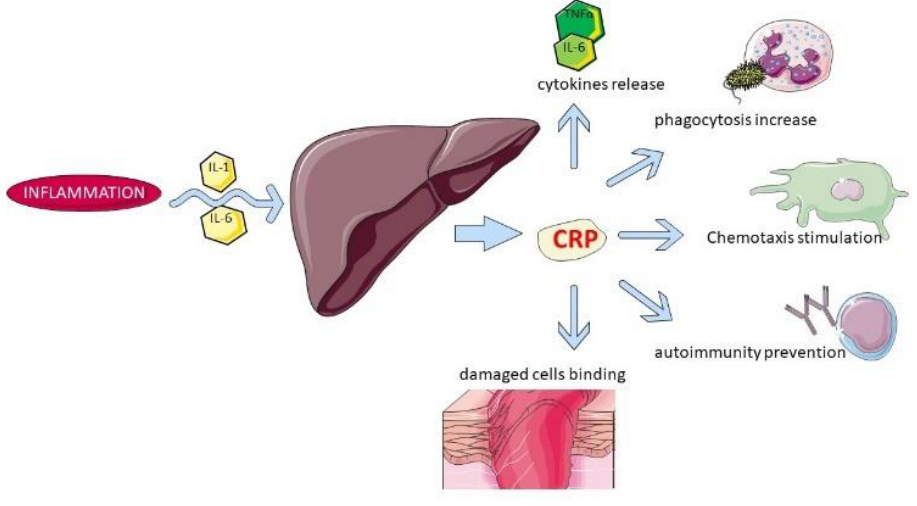
Figure 1. Factors inducing acute phase response, including CRP. The changes in APPs are species-specific. C-reactive protein (CRP) is a major positive APP in dogs, and it is the most sensitive APP in this species [3]. Canine CRP has a molecular weight of approximately 100 kDa and consists of 5 subunits with an apparent molecular weight (MW) of approximately 20 kDa each [4]. It is mostly produced after proinflammatory stimulation by cytokines such as IL-1, IL-6, and tumor necrosis factor- α (TNF- α ) [5]. The blood concentration of CRP changes dramatically within 4–6 h after the inflammatory stimulus and reaches its maximum concentration after about 24–48 h, which in most cases reflects the physical degree of tissue trauma. Some of the CRP’s biological functions are shown in Figure 2.